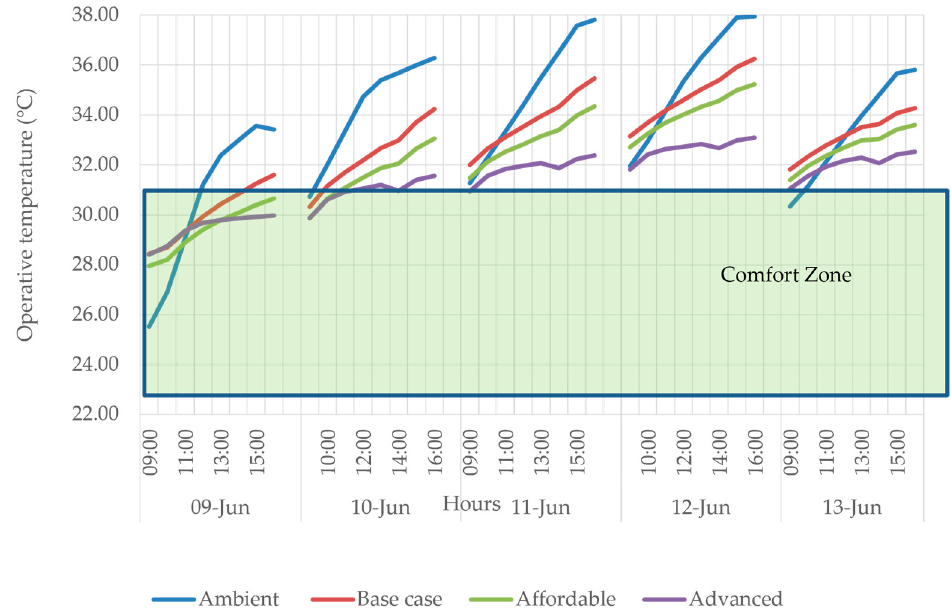
Figure 9. Reduction in temperature from the BC in a summer